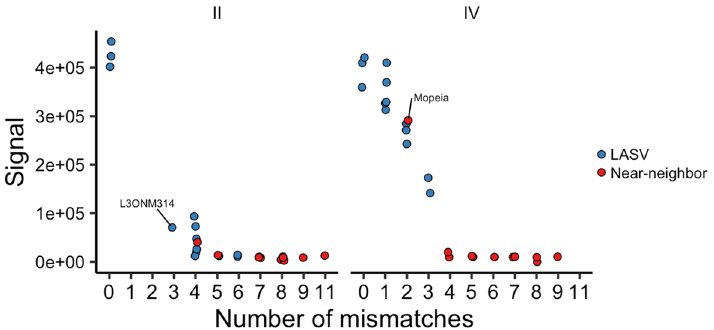
Figure 4. Fluorescent signal obtained for crRNA #5 spacer/target pairs with different numbers of mismatches. The circles represent all spacer/target pairs tested for crRNA #5_LII (left panel) and #5_LIV (right panel). While generally higher number of mismatches correlates with lower signal, the pairs with the same number of mismatches (e.g. 3 mismatches) can have variable signal depending on other features of the pairing (mismatch distribution—IQR, PFS nucleotides, etc.).